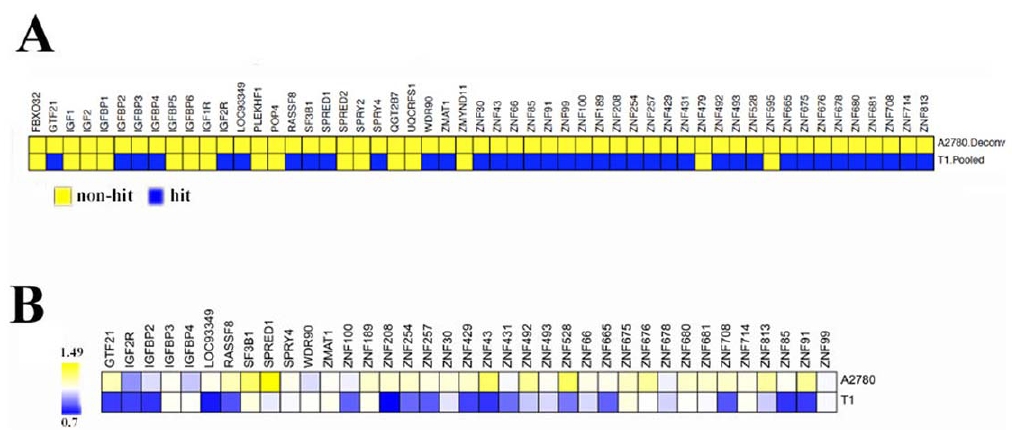
Figure 1. siRNA screen identifies GIST-specific IM sensitizing genes. (A) Primary IM sensitizing hits (SI , 0.85, blue) identified using pooled siRNAs in A2780 (0 hits) and T1 cells (37 hits). (B) Validation of the primary IM sensitizing hits using deconvoluted siRNA screen. 17 of the primary hits were validated. Heatmap shows the average SI values from two or more confirmed individual siRNAs. SI values on log scale are plotted.